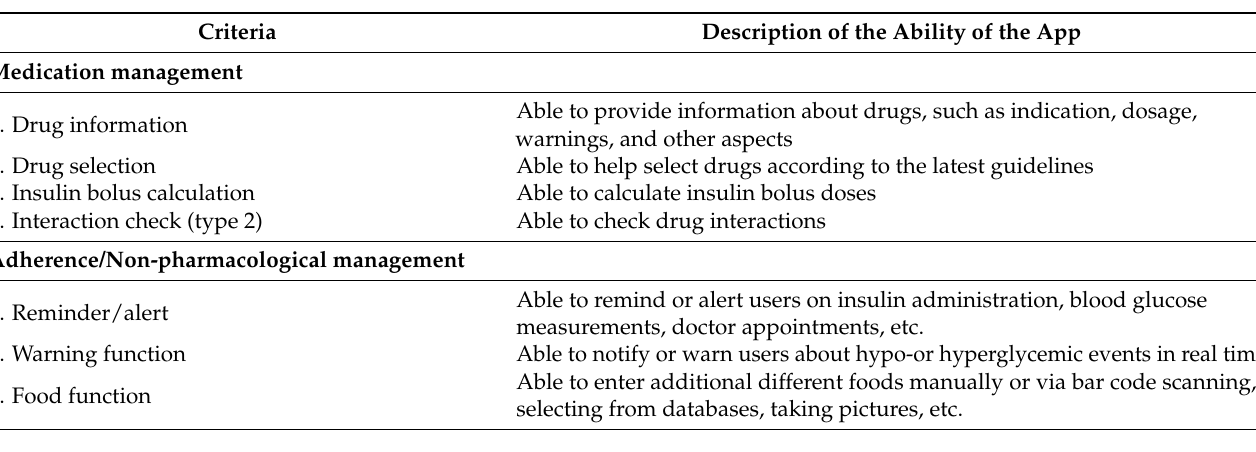
Table 1. Description of criteria relevant to digital pharmaceutical care for patients with